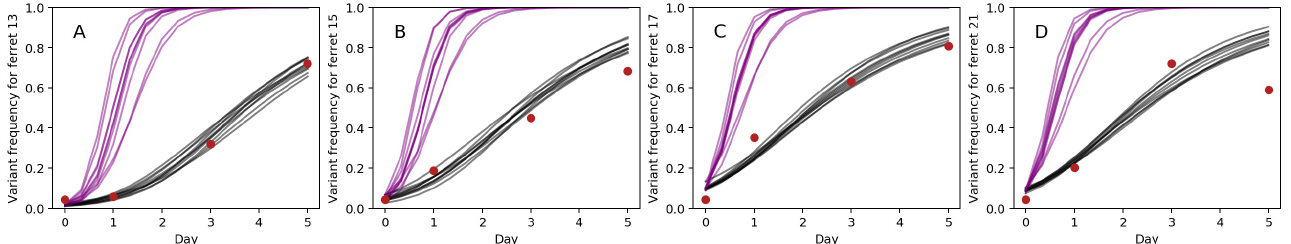
Figure 4. Deterministic model simulations (grey lines) and observed data points (red dots) are shown for ( A ) ferret 13, ( B ) ferret 15, ( C ) ferret 17, and ( D ) ferret 21. Only days 0, 1, and 3 were used in model fitting. Parameters for the model simulations were drawn from the posterior distributions of the parameters. Purple lines show model simulations under the same parameterizations of variant fitness and initial variant frequencies as the grey lines, but simulated in the absence of cellular coinfection. These no-coinfection projections were simulated using Equation